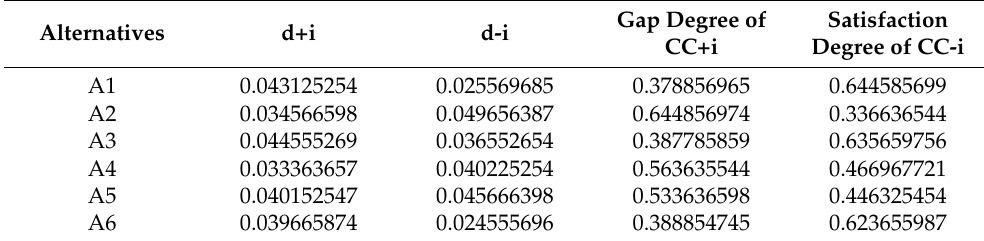
Table 9. Closeness Coefficients of Various